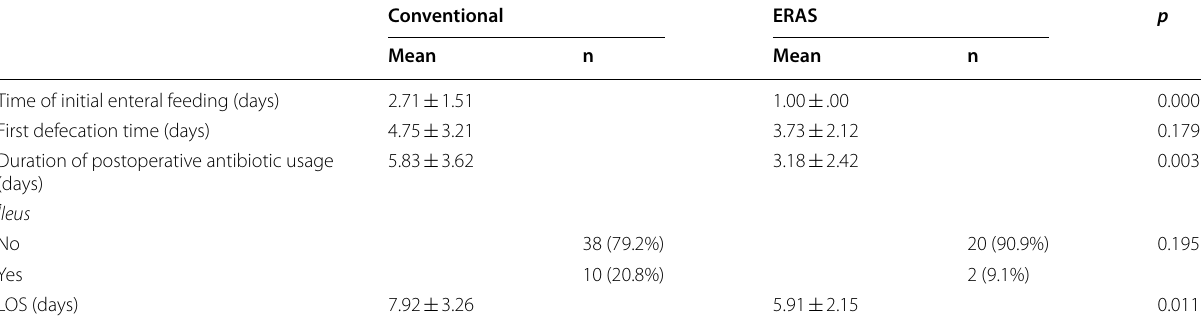
Table 2 Comparison of postoperative data of patients